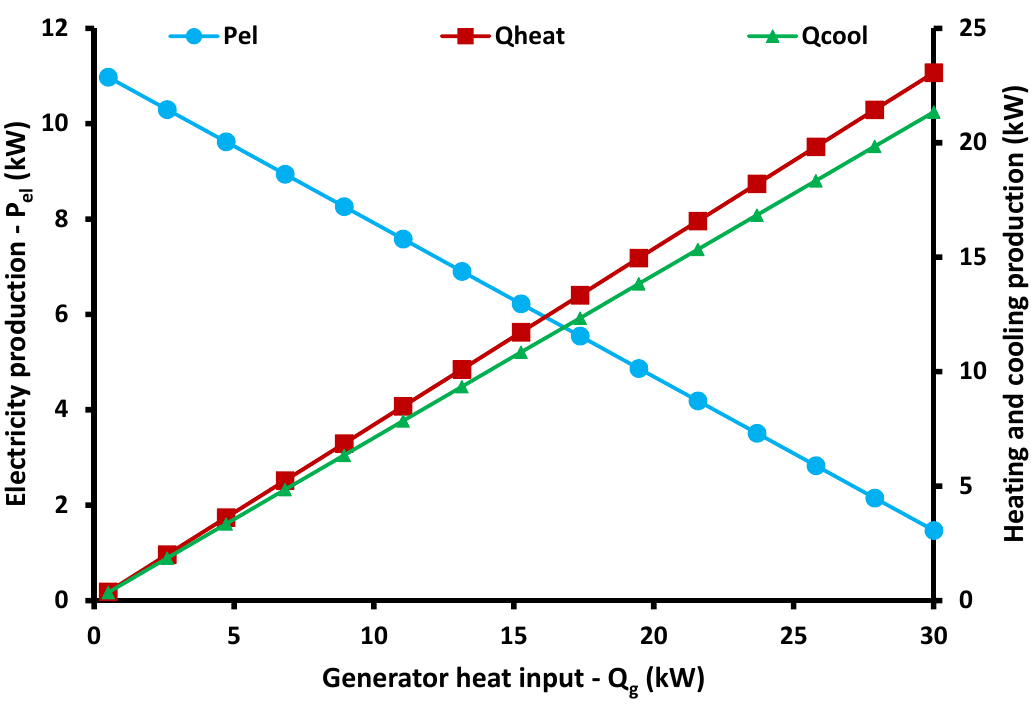
Figure 11. Electricity, heating, and cooling for different generator heat input values.